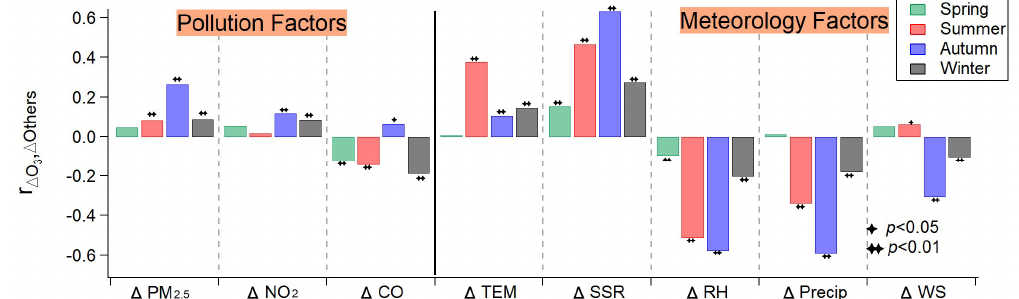
Figure 6. Pearson correlation coefficients of O 3 difference ( ∆ O 3 ) between the years 2016 and 2019 with that for other pollutants ( ∆ PM 2.5 , ∆ NO 2 and ∆ CO) and meteorological factors (temperature ( ∆ TEM), surface net solar radiation ( ∆ SSR), relative humidity ( ∆ RH), total precipitation ( ∆ Precip) and wind speed ( ∆ WS)) for all seasons. The significance test of passing with p < 0.05, p < 0.01 or failure is indicated by one star, two stars or no indicator over the top of each bar, respectively.